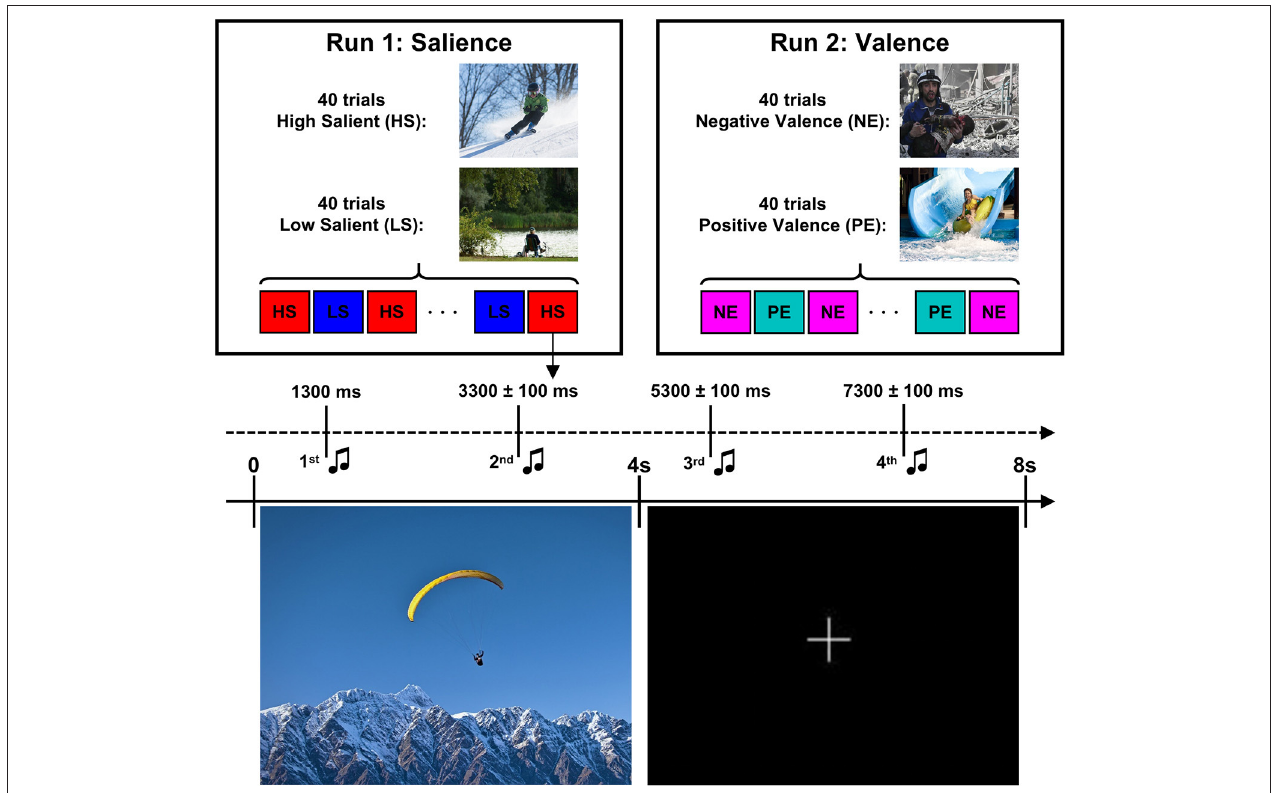
FIGURE 2 | Design of the Attention Modulation by Salience Task. The task consistent of two runs of 80 trials each. Each trial consisted of presentation of a visual stimuli (high salient/low salient pictures in run 1 or negative/positive pictures in run 2) for 4s followed by a presentation of fixation cross for another 4s. Four tones (ascending or descending) were presented starting after 1,300ms after picture offset with inter-tone interval of 2,000 ± 100ms. Images for this illustration were taken from (https://zen.yandex.ru/) while the actual experiment used IAPS pictures.